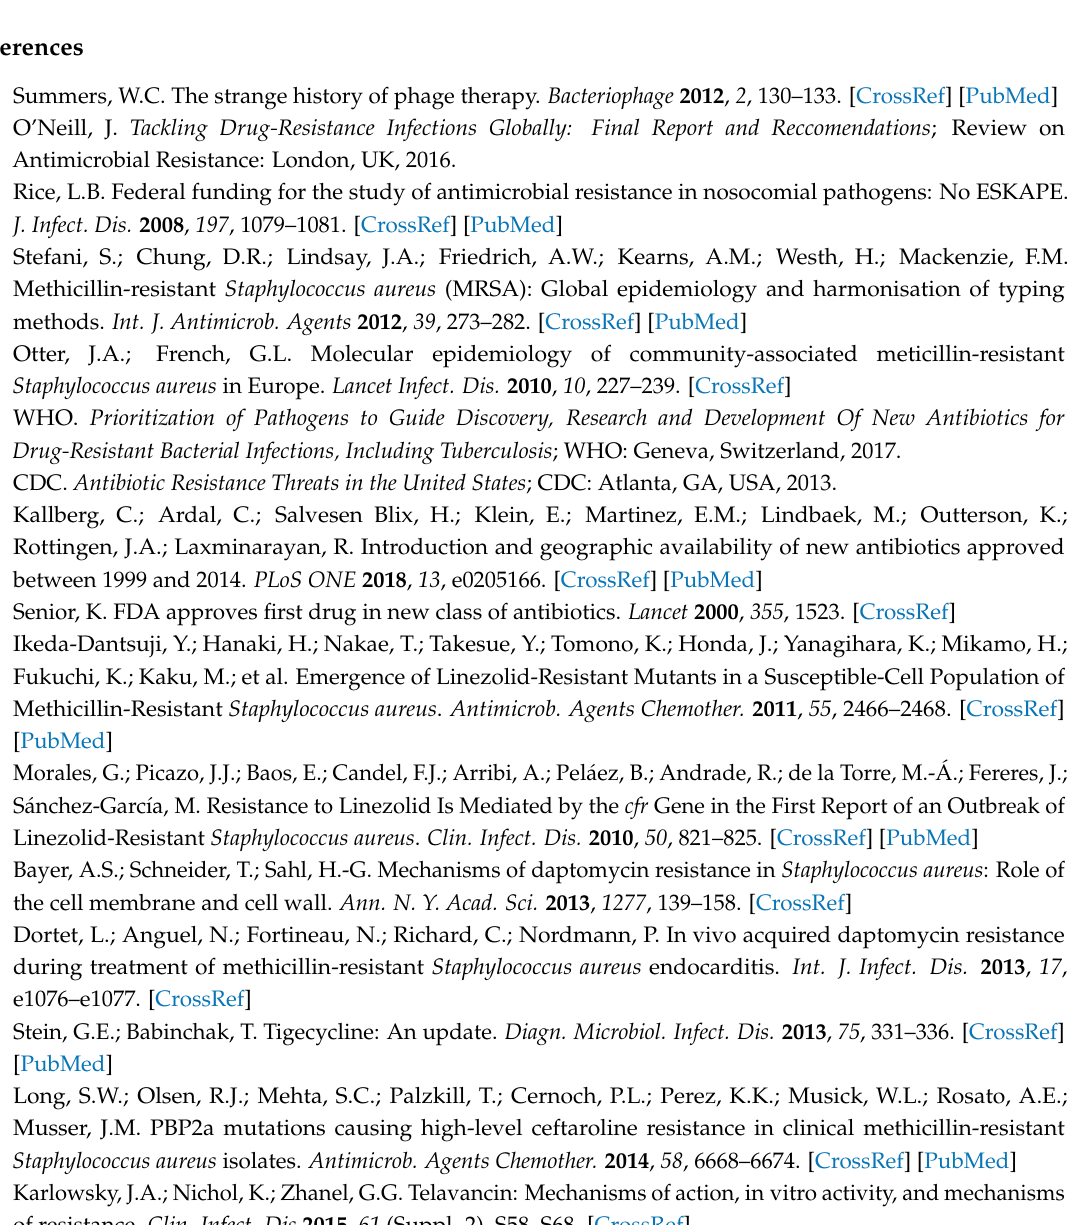
Table S1: Phage sensitivity of S. aureus strains with known